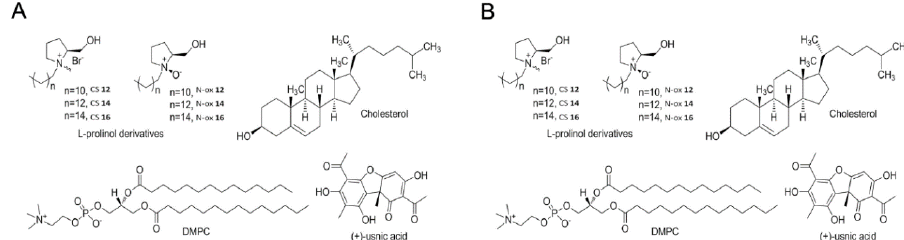
Figure 3. Molecular structure of liposome components and of usnic acid (UA) used in ( A ) study of